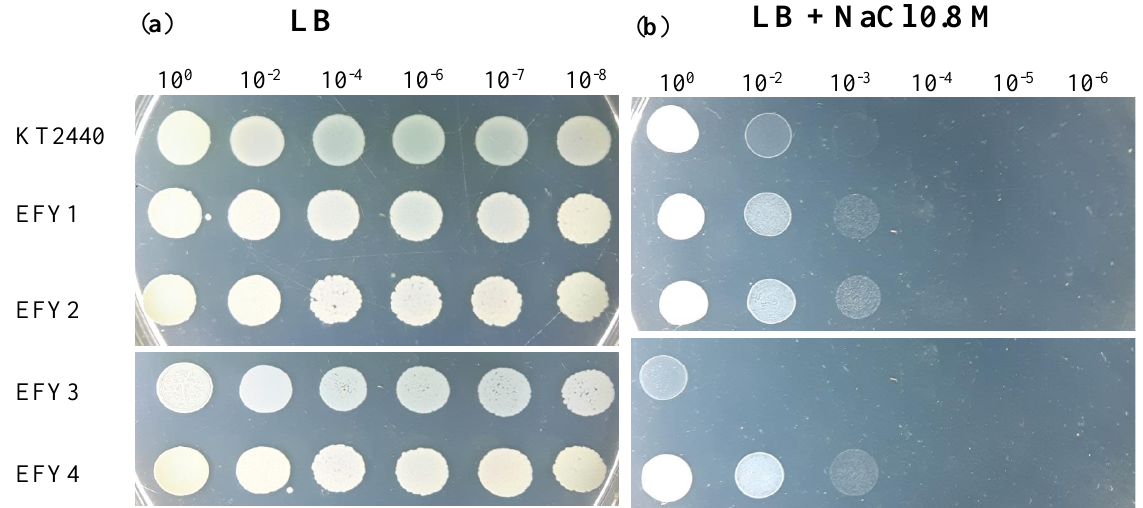
Figure 2. Growth of P. putida KT2440 and strains EFY1, EFY2, EFY3, and EFY4 on solid medium ( a ) LB and ( b ) LB + 0.8 M NaCl. Ten microliters of 10-fold serial dilutions of the bacterial cultures were plated on the plates. Images were taken after incubating the plates at 30 °C for 24 h.